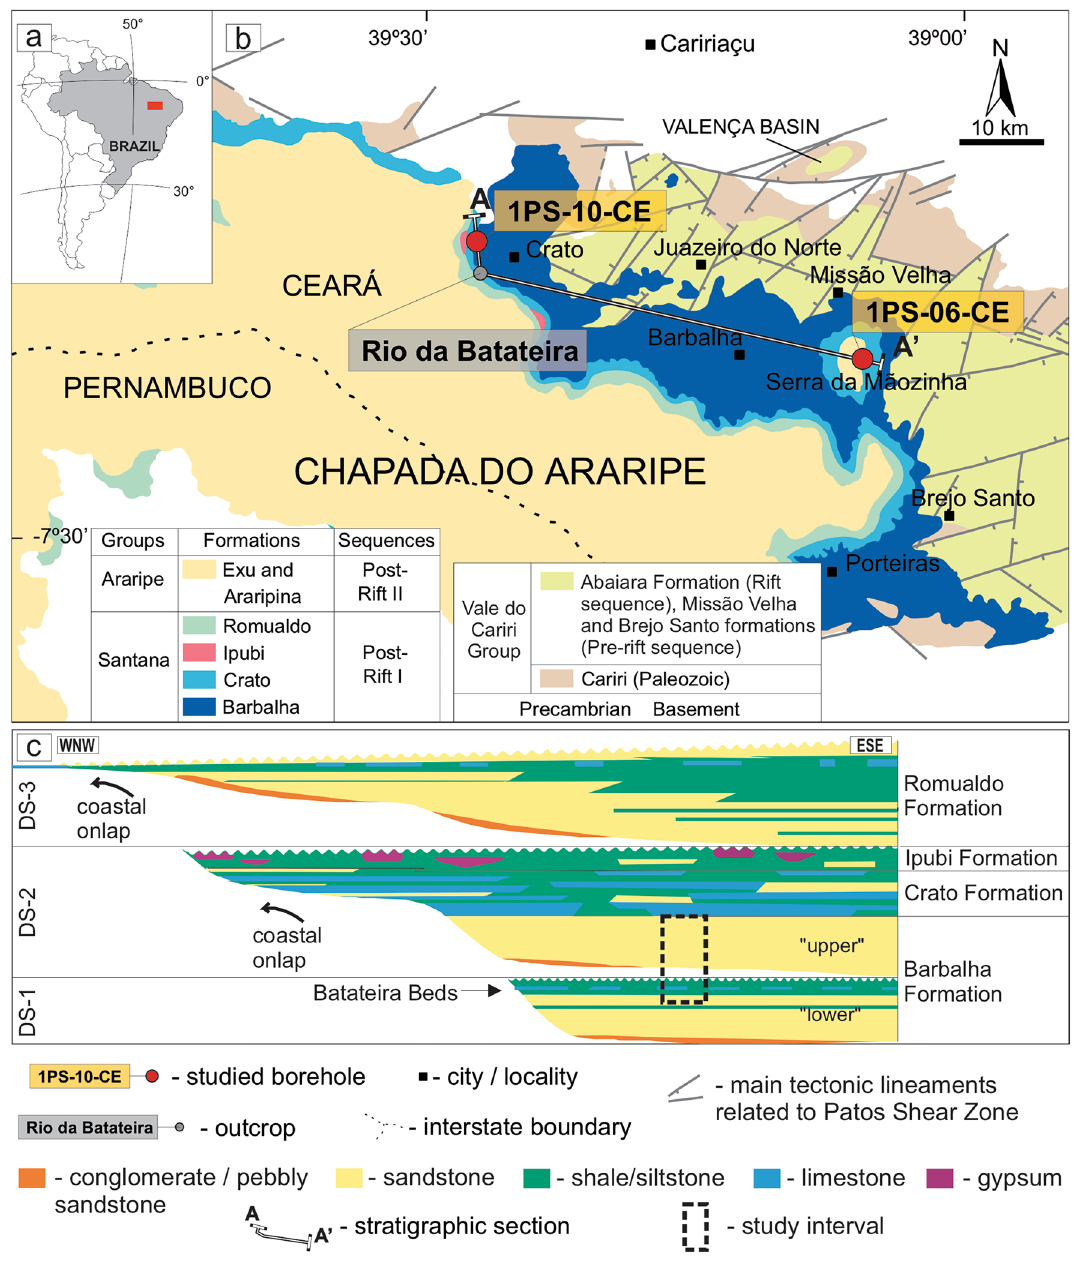
Figure 1. Geographic location and stratigraphic position of the studied area. ( a ) Map of South America and studied area (red polygon). ( b ) Simplified geological map of the Araripe Basin with location of the boreholes used in this study, modified from Assine et al. 8 . ( c ) Stratigraphic framework of the Alagoas Post-rift Stage in the Araripe Basin, composed of three depositional sequences bounded by disconformities. DS-1 depositional sequence 1, DS-2 depositional sequence 2, DS-3 depositional sequence 3, modified from Assine et al. 8 . Graphic art made with CorelDRAW Graphics Suite × 6, version 16.0 (https:// www. corel draw.